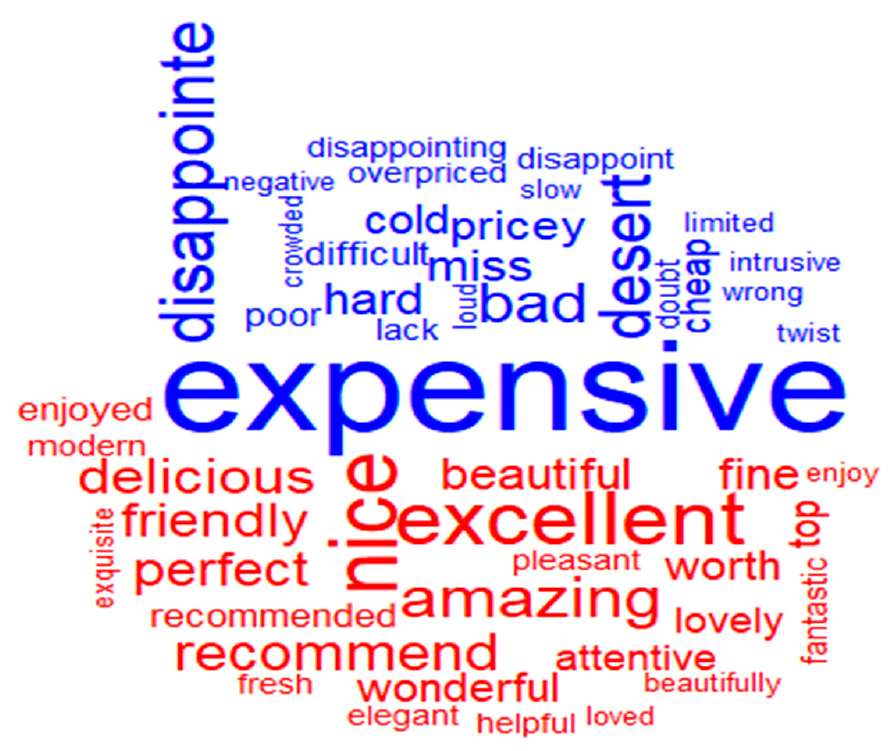
Figure 3. Most common positive and negative words in the total number of reviews for the whole period of time.